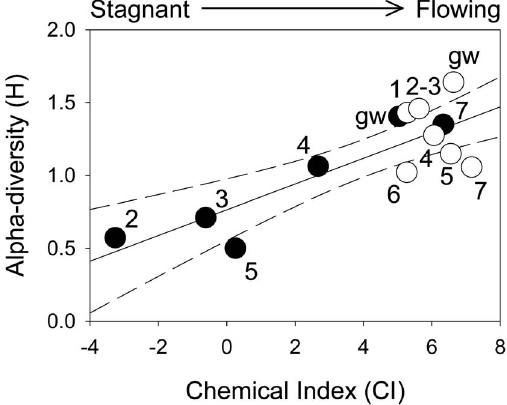
Figure 5. Chemical Index vs alpha-diversity. Relationship between biogeochemical conditions (expressed as Chemical Index – CI= log([O 2 ]/[N-NH 4 ])) and the alpha-diversity index (r=0.82; p , 0.05). s=summer; a=autumn.